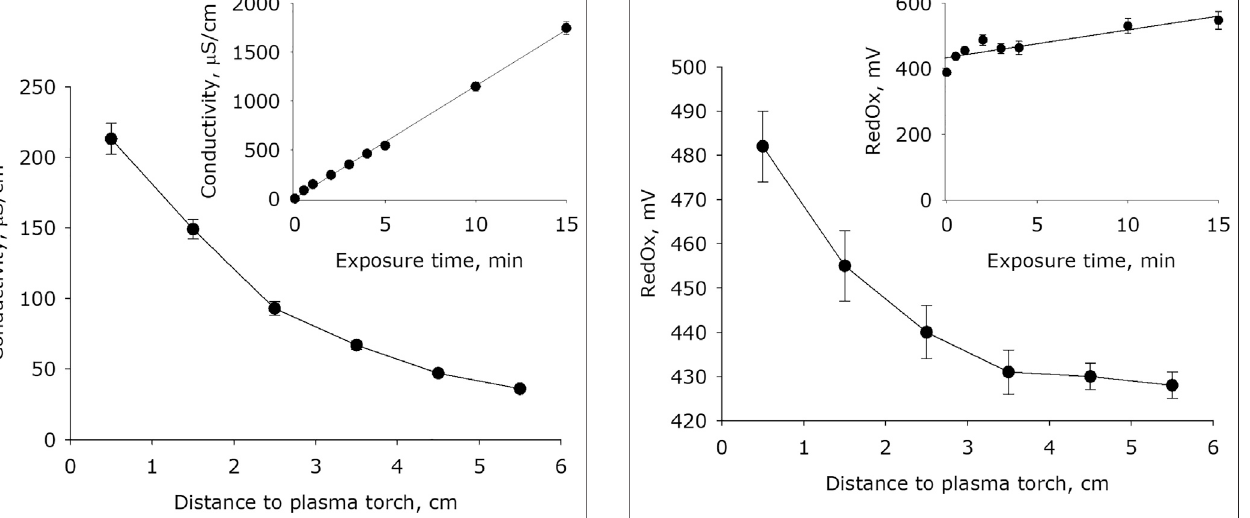
FIGURE 4 | The water electrical conductivity dependence on distance from water surfacetothe plasma jetnozzleat 1 minofplasmaexposure.Data are presented as mean standard error for three independent experiments. Inset shows the water electrical conductivity depending on the time of plasma exposure at 1.5 cm distance from water surface to the plasma jet nozzle. The data are presented as average values with standard deviation of three experiment repetitions.